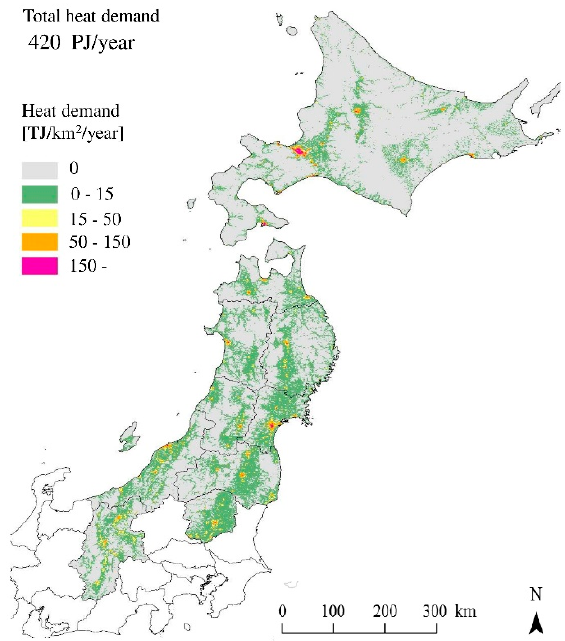
Figure 7. Heat demand map in 1 km mesh resolution. Table 3. Analytical result of DHS designs by prefecture.